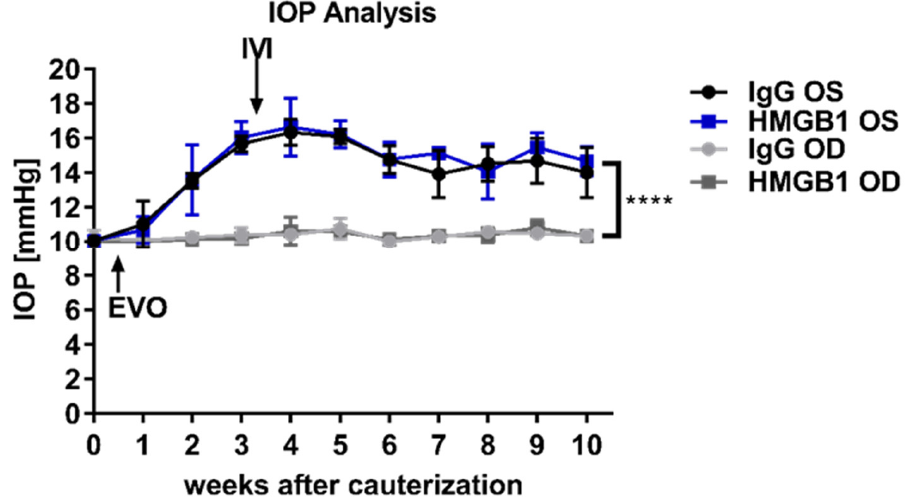
Figure 1. Follow-up of IOP elevation. IOP was measured once a week using TonoLab. After episcleral vein obliteration (EVO), IOP increased to a stable level within three weeks. After achieving a stably elevated IOP, intravitreal injection (IVI) was performed into OS. **** p < 0.0001, Student’s t -test.